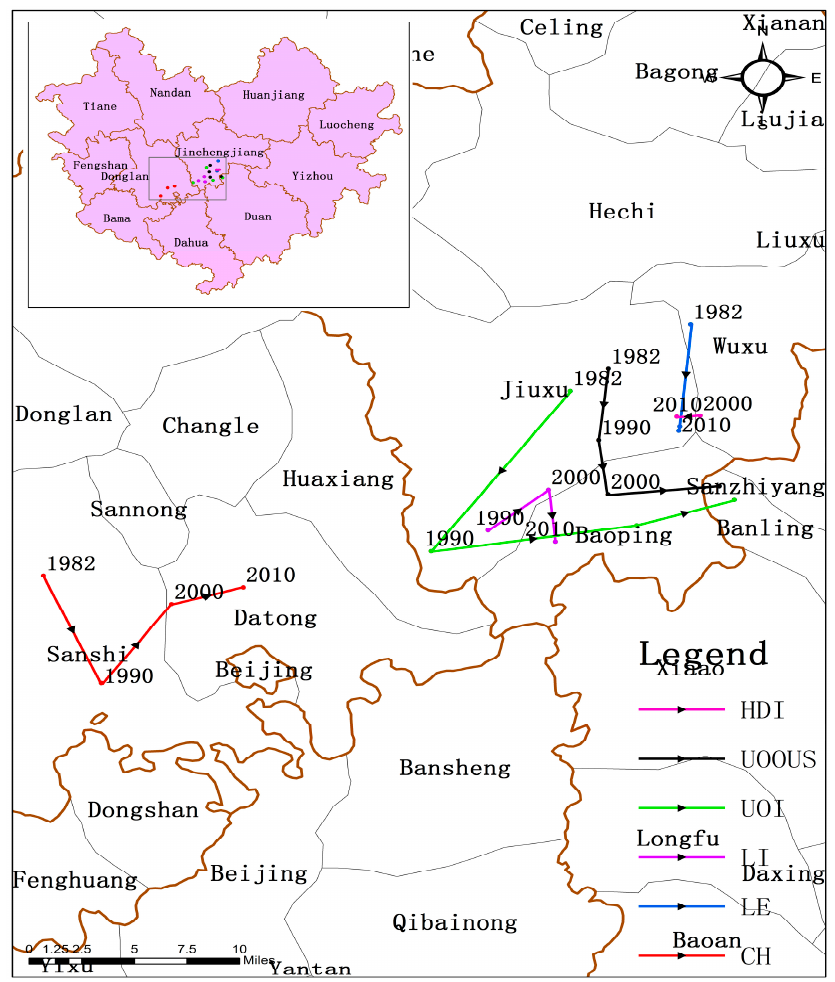
Figure 4. The curve of gravity center migration on longevity indicators (CH, UOOUS, UOI and LI) and